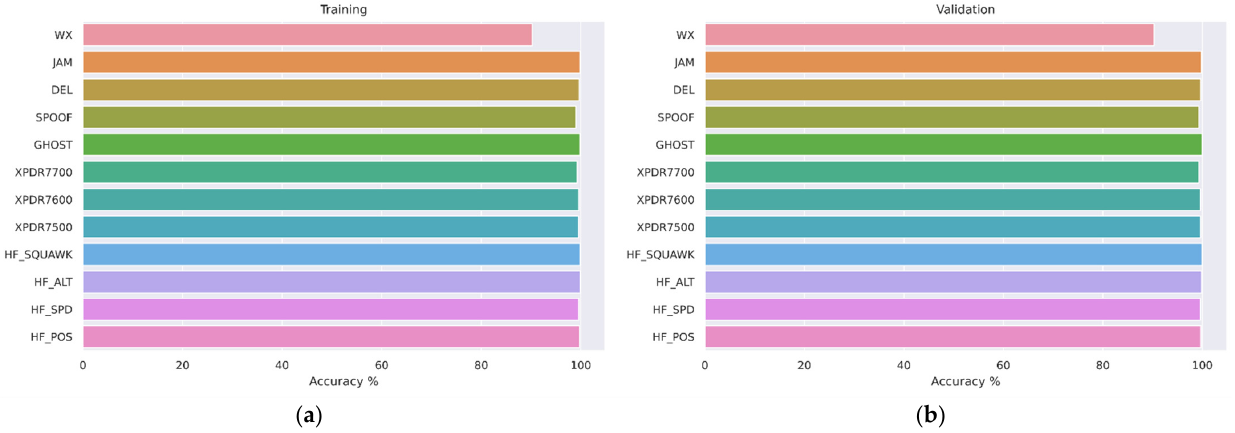
Figure 16. RNN model accuracy for WX, JAM, DEL, SPOOF, GHOST, XPDR7700, XPDR7600, XPDR7500, HF_SQUAWK, HF_ALT, HF_SPD, and HF_POS. ( a ) Training accuracy of the applied RNN models; ( b ) Validation accuracy of the applied RNN models.